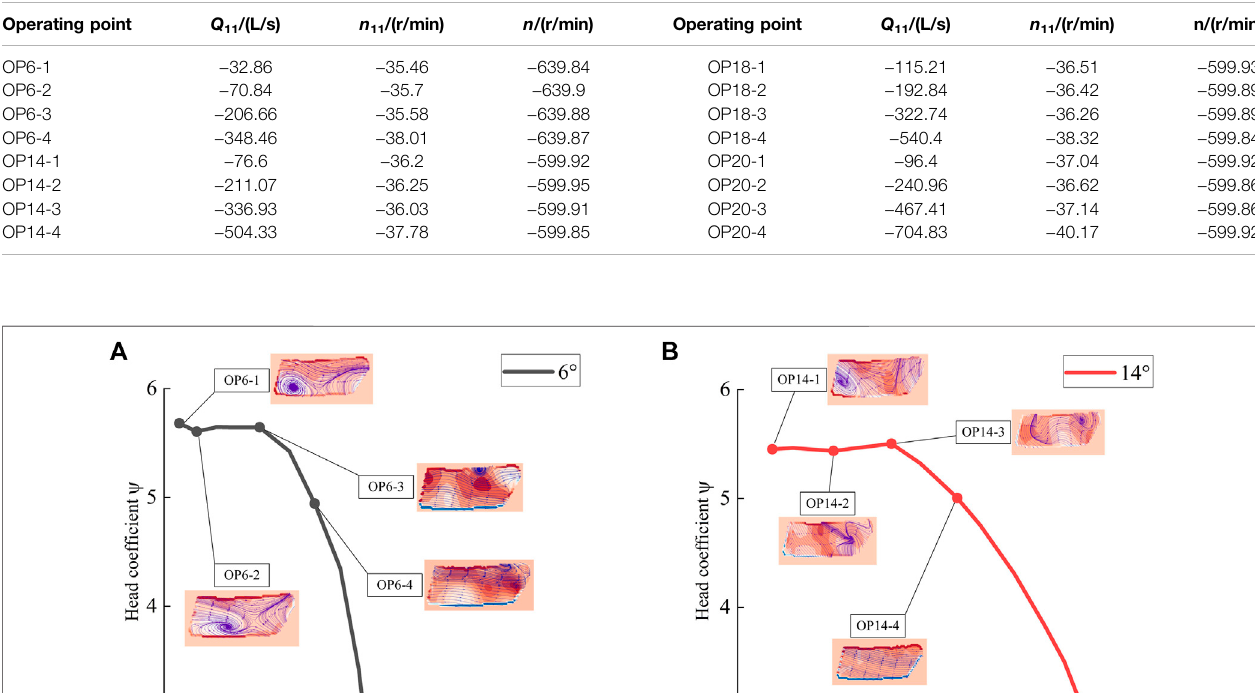
Frontiers in Energy Research |